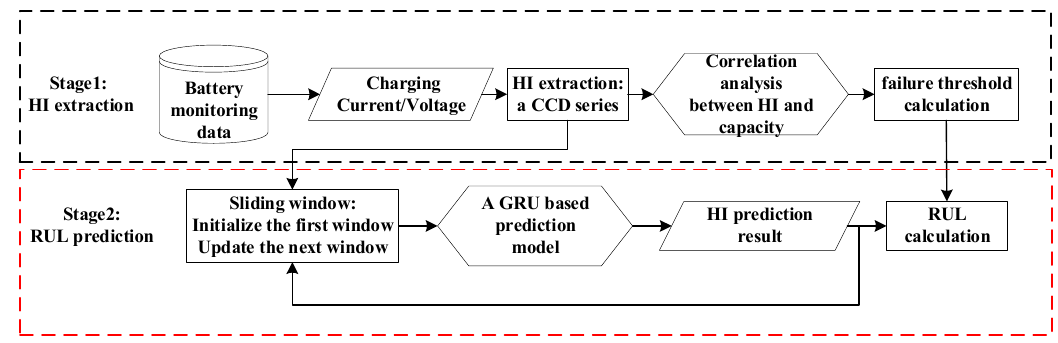
Figure 3. The RUL prediction model.